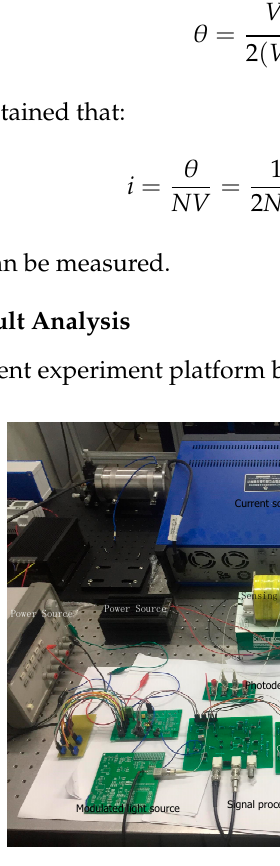
Figure 4. DC measurement experiment platform.